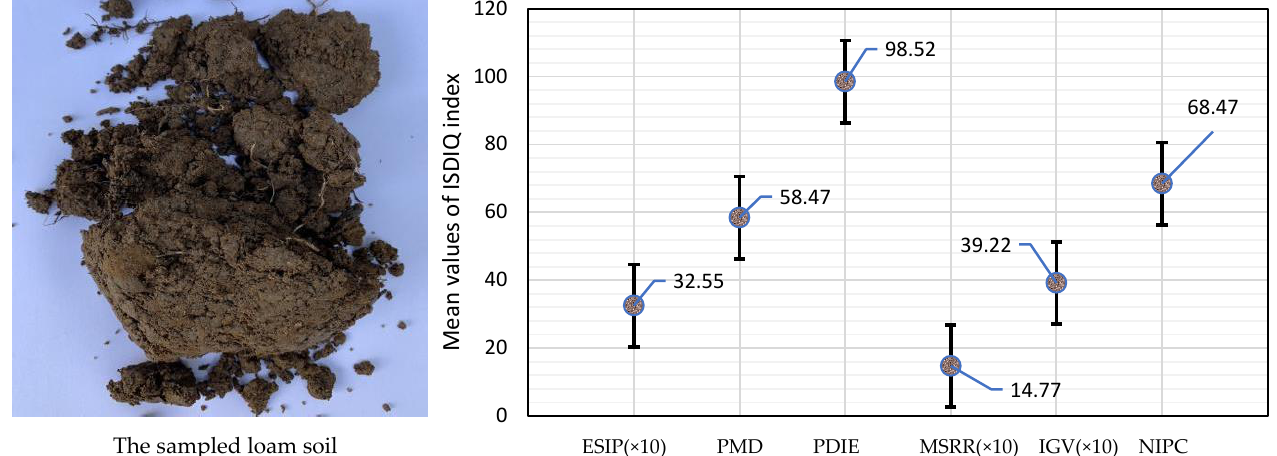
Figure 8. The loam soil specimen and its corresponding SDIQ index values obtained from the sampled layer E.